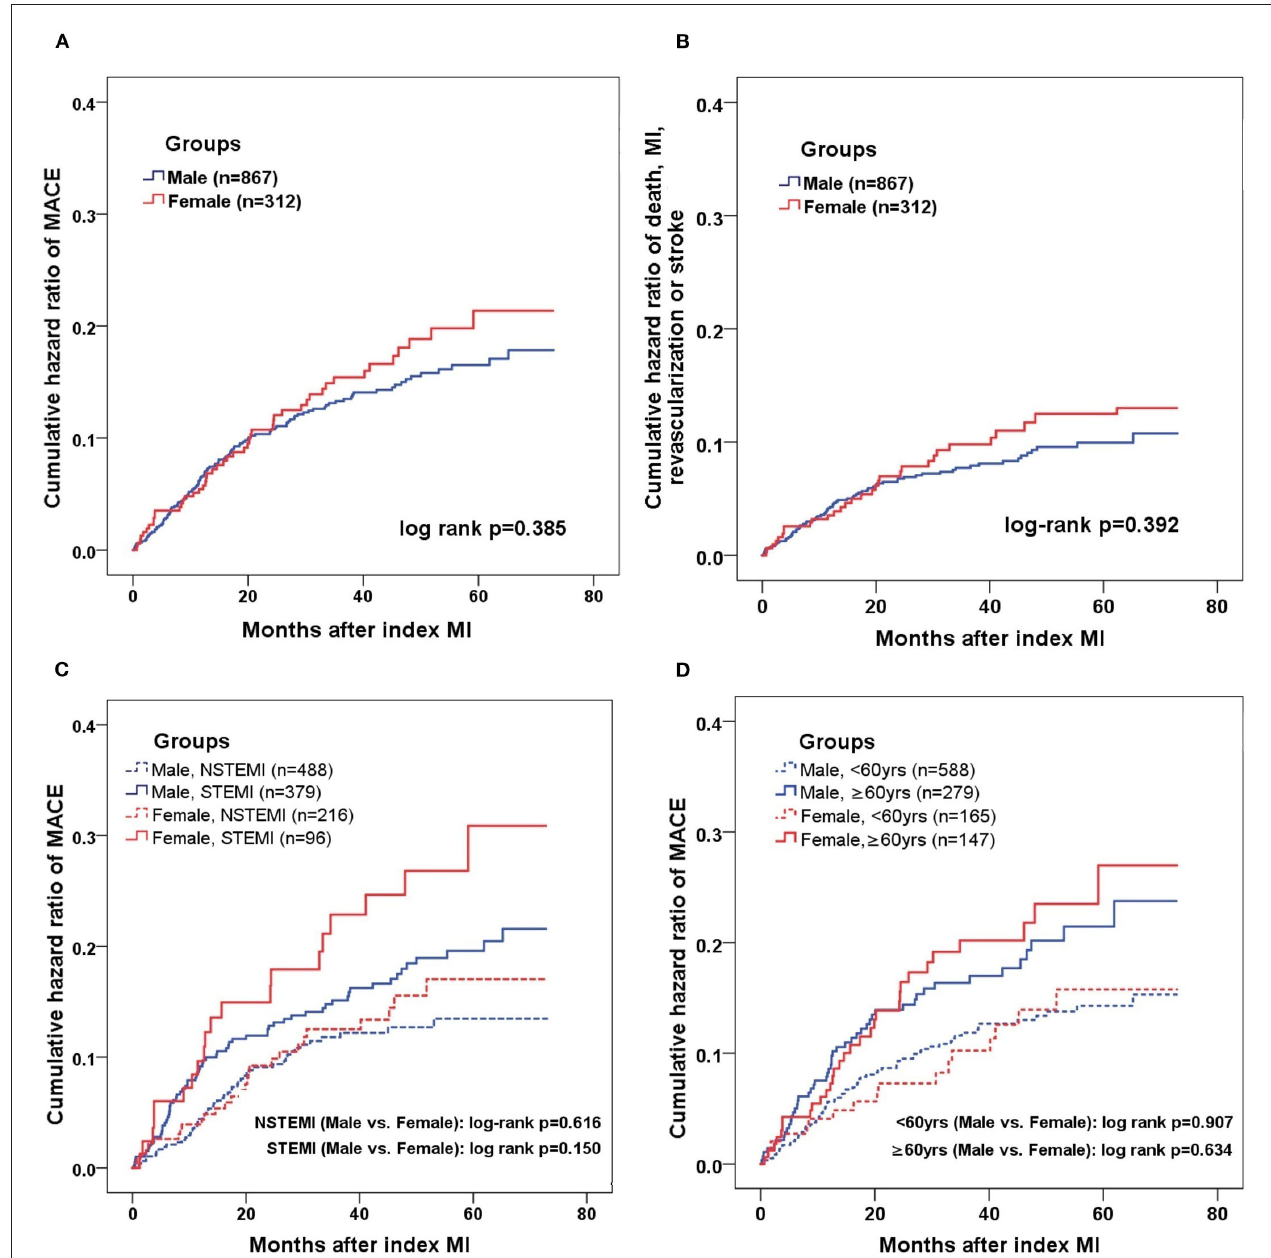
FIGURE 2 | Kaplan-Meier analysis of MACE in male and female MINOCA patients. Kaplan-Meier curves showing the cumulative incidence of MACE (A) and composite “hard” endpoint of death, non-fatal MI, non-fatal stroke, or revascularization (B) in men and women presenting with MINOCA. Male and females were further stratified by MI type (C) and age (D) . The threshold of 60 years was used to define the younger or older. MACE included all-cause death, non-fatal MI, revascularization, non-fatal stroke, and hospitalization for unstable angina or heart failure. STEMI, ST-segment elevation myocardial infarction; NSTEMI, non-ST-segment elevation myocardial